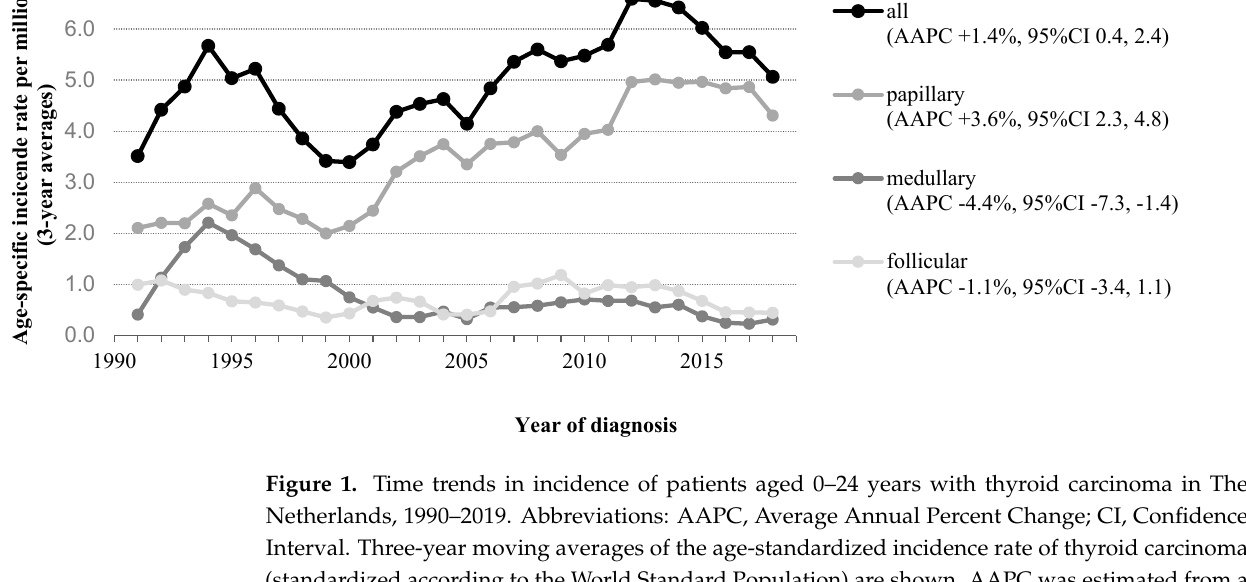
all (AAPC +1.4%, 95%CI 0.4, 2.4)